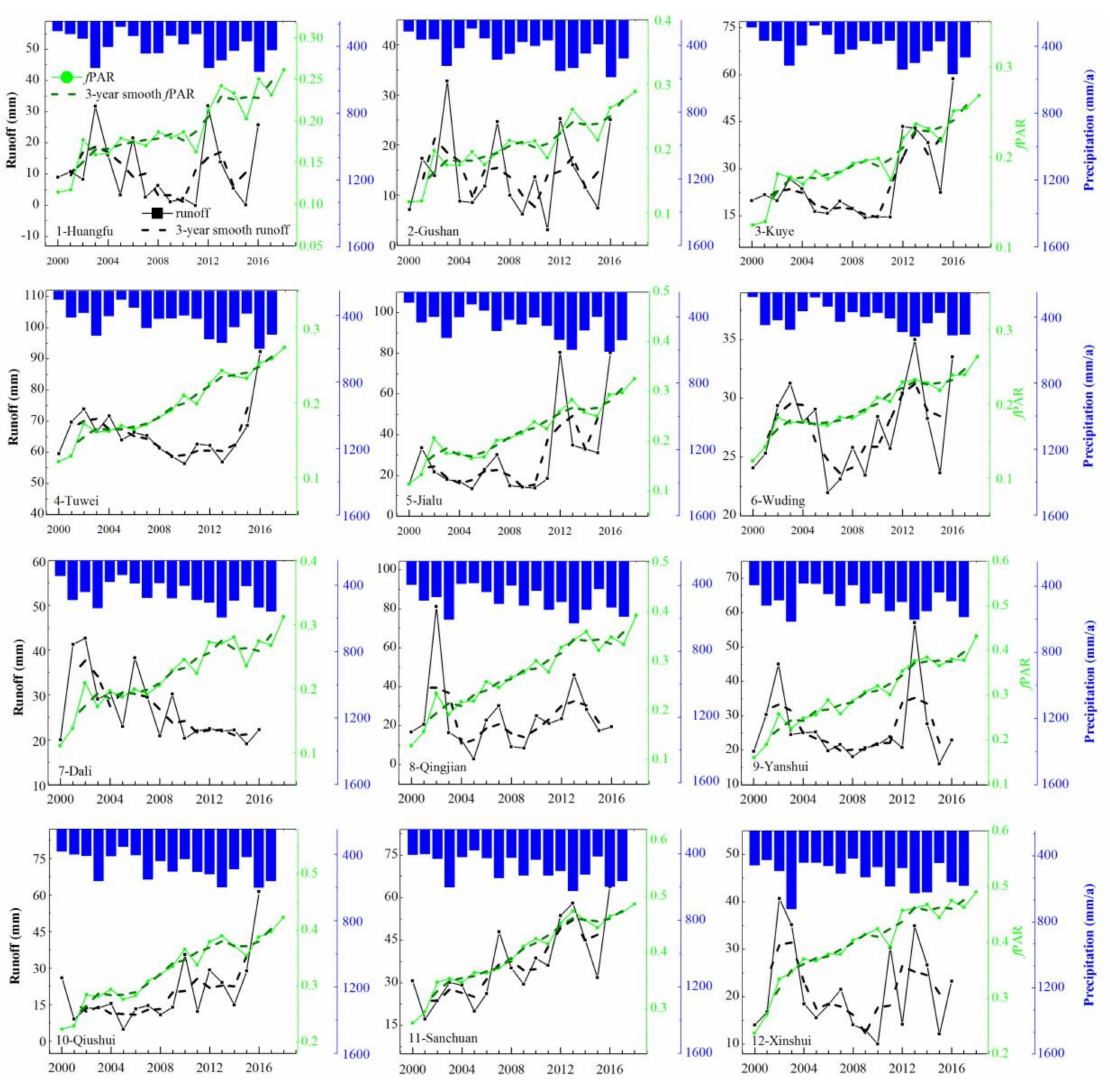
Figure 7. Variation in the annual runo ff , f PAR, and precipitation throughout the 12 watersheds. The black and green lines are annual runo ff and f PAR, respectively, and the dashed lines represent the three years’ smooth average. The blue bars depict the annual